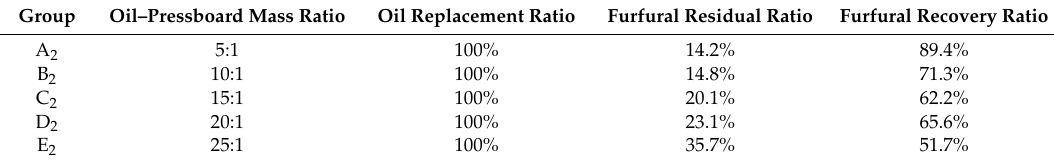
Table 3. Furfural residual and recovery ratio.